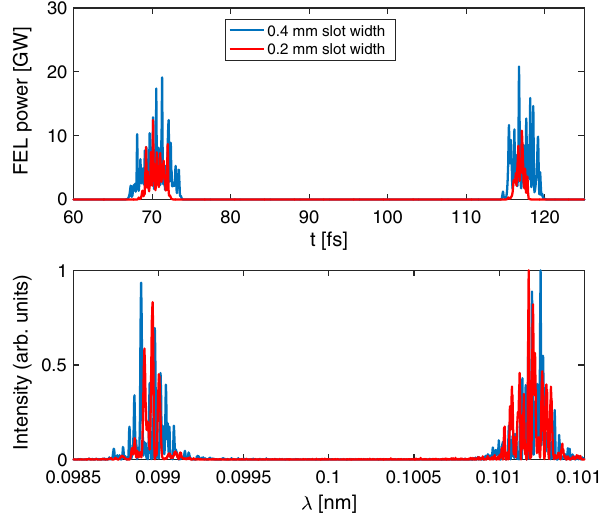
FIG. 5. Longitudinal phase space of the electron beam at the entrance of the undulators showing two beam spikes with 1.09% energy difference and 14 . 1 μ m separation.